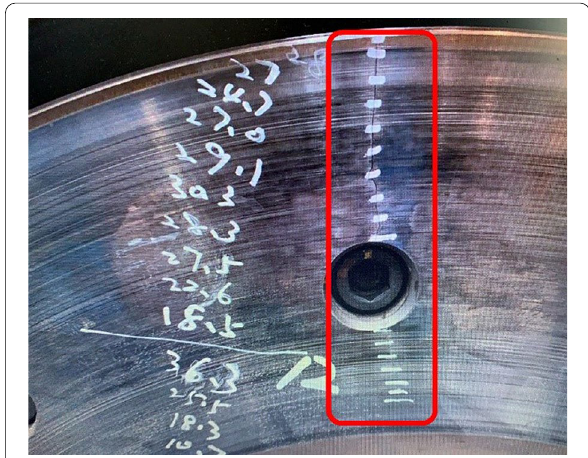
Figure 1 Fatigue crack at the bolt hole edge of the wheel-mounted brake disc